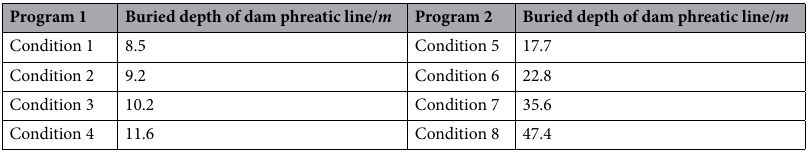
Table 7. Buried depth of dam phreatic line under different conditions.